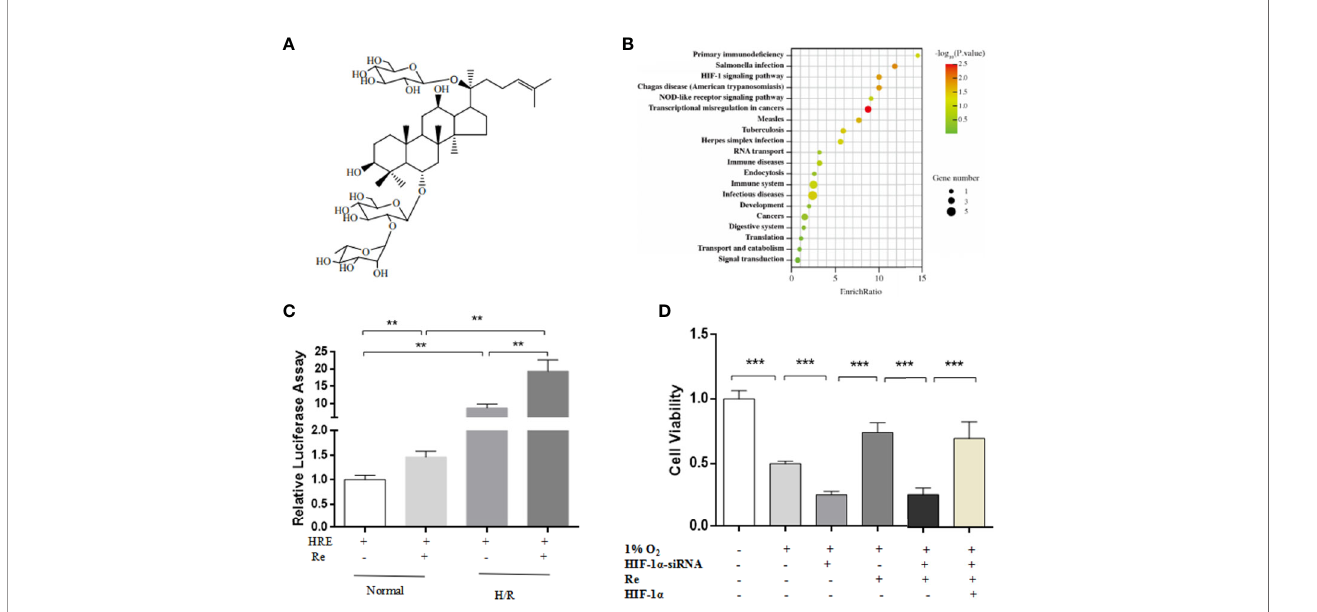
FIGURE 2 | HIF Signaling pathway was predicted by notework pharmacology and vadaliated by luciferase assay and gene siliencing. (A) Molecule structure of ginsenoside Re. (B) Signaling pathway predictd by network pharmacology. (C) Expression of HIF-1 a signaling pathway was examined by relative luciferase assay (n = 5).